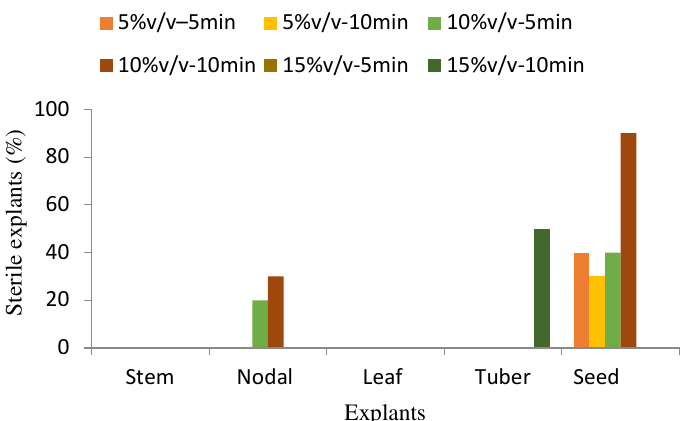
Figure 1. Effect of different concentrations of NaClO solution on surface sterilization of P. erosus explants (n=10)